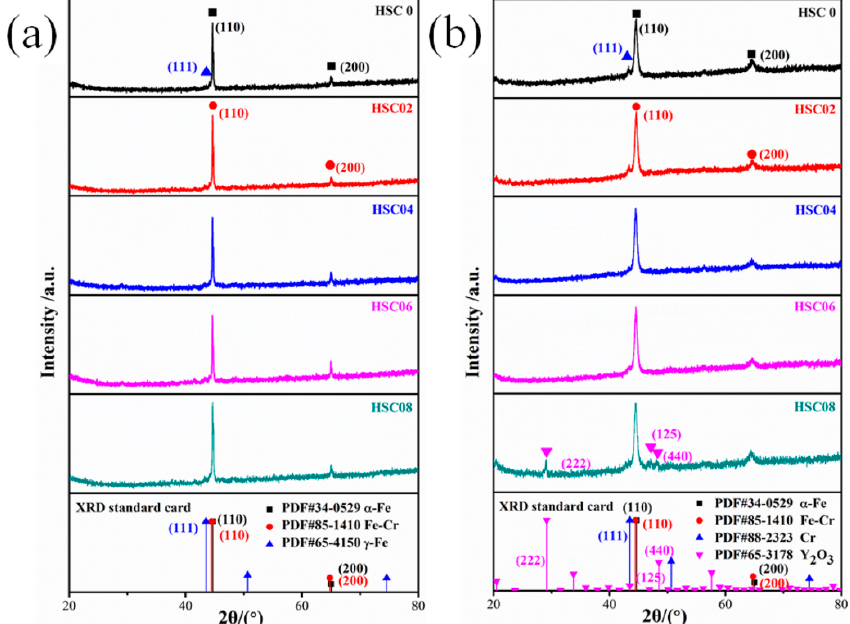
Figure 4. ( a ) XRD spectra and phase composition of the alloy powder samples, ( b ) XRD spectra and phase composition of the coating samples.